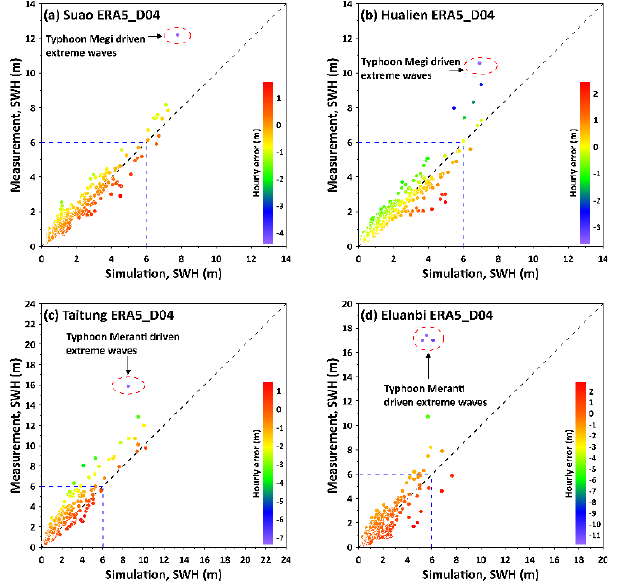
Figure 5. Hourly differences in significant wave height between the measurement and simulation data for the ( a ) Suao, ( b ) Hualine, ( c ) Taitung, and ( d ) Eluanbi wave buoys employing D04 (domain 04) and the SCHISM-WWM-III with ERA5 winds.